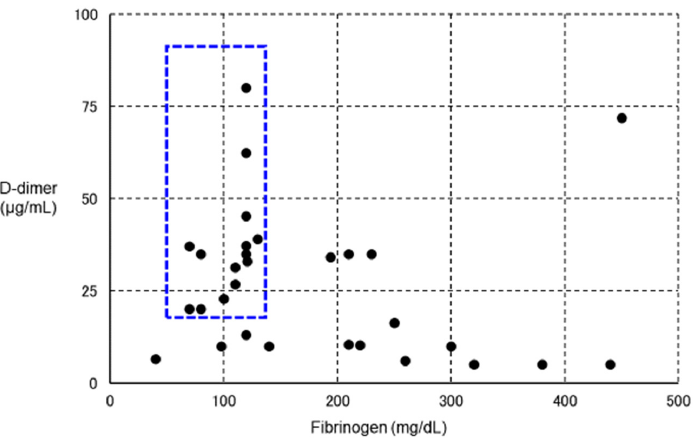
Figure 4. Relationship between VITT and fibrinolytic pathophysiology. We plotted fibrinogen on the horizontal axis and D-dimer on the vertical axis for 30 definitive VITT cases (using data from Reference [222]) in which both fibrinogen and D-dimer values were known. The lower the level of fibrinogen, the higher the level of D-dimer. In particular, patients with blue dotted squares showed